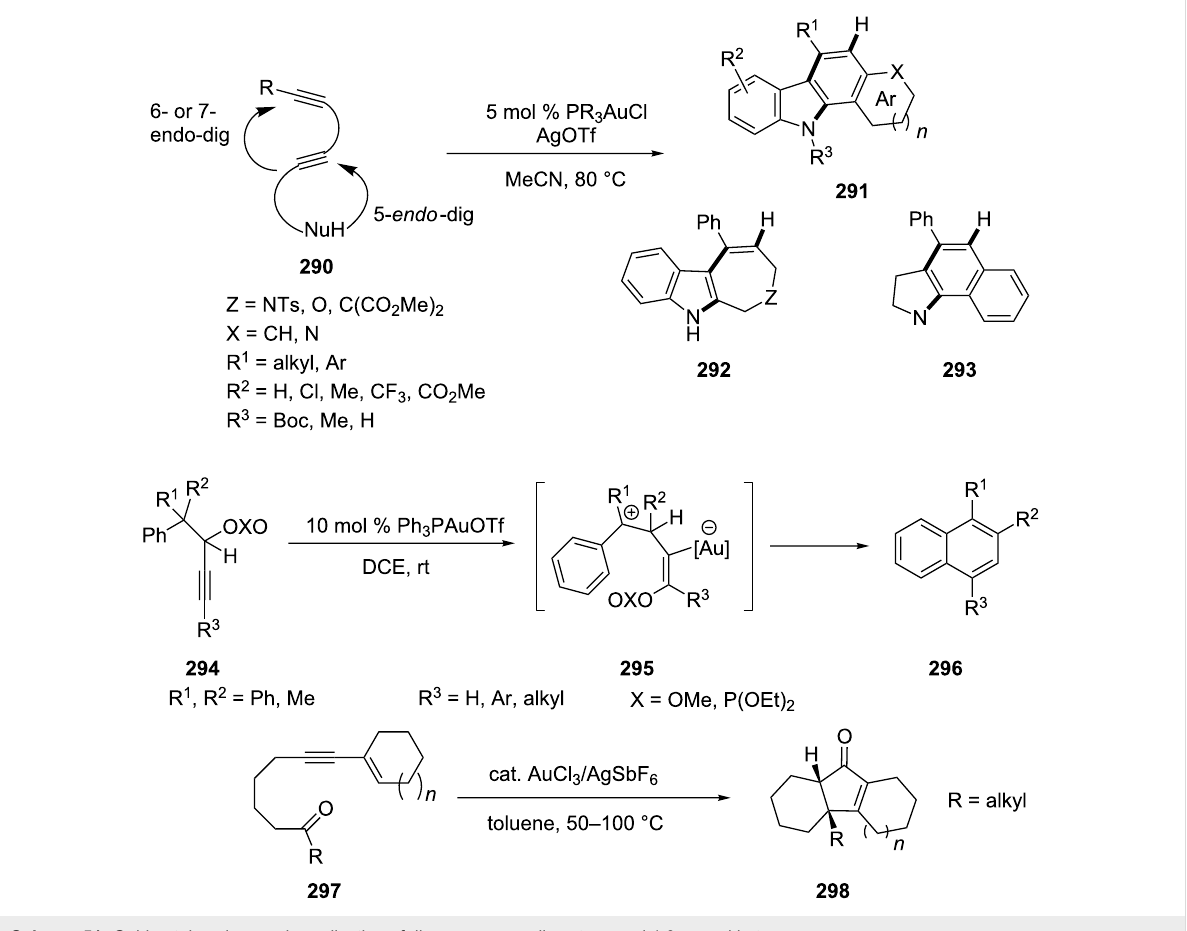
Scheme 51: Gold-catalyzed cascade cyclization of diynes, propargylic esters, and 1,3-enynyl